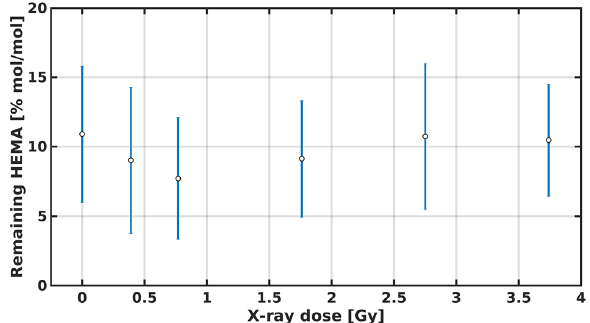
10 B samples irradiated at different X-ray doses.